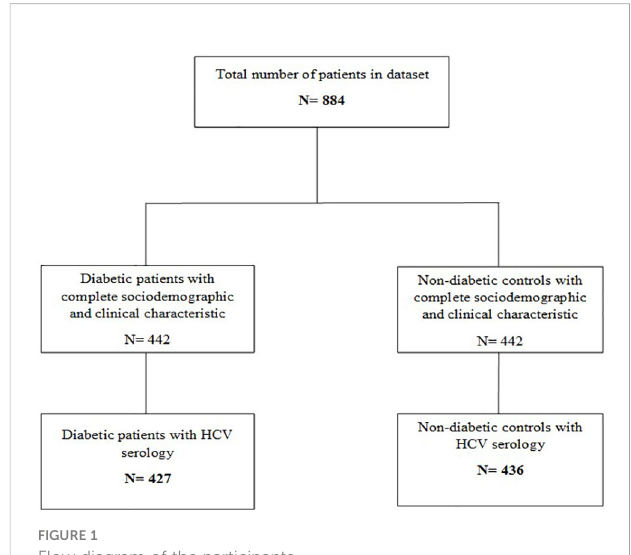
FIGURE 1 Flow diagram of the